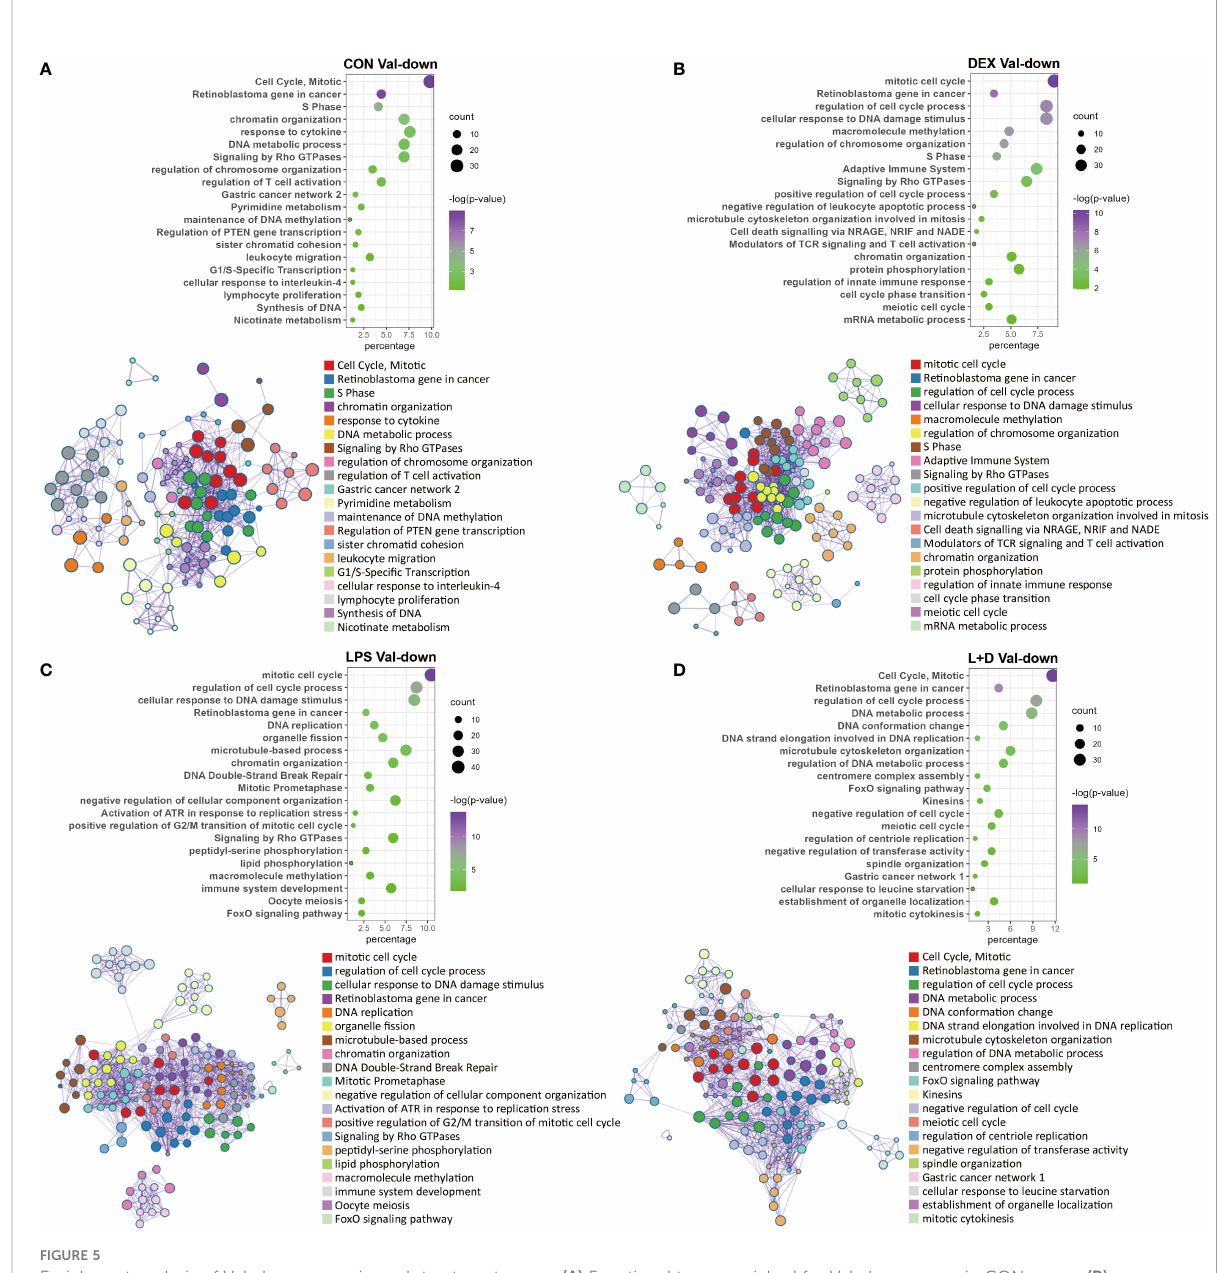
FIGURE 5 Enrichment analysis of Val-down genes in each treatment group. (A) Functional terms enriched for Val-down genes in CON group. (B) Functional terms enriched for Val-down genes in DEX group. (C) Functional terms enriched for Val-down genes in LPS group. (D) Functional terms enriched for Val-down genes in LPS+DEX group. Enrichment analysis was performed using the Metascape. Bubble plots illustrate signi fi cance and gene counts of top enriched terms, where purple indicates higher signi fi cance and green indicates lower signi fi cance and bubble size is positively correlated with gene counts. Networks illustrate the relationship between terms, where each node represents one functional term and terms with Kappa similarities above 0.3 are connected by edges. Each term cluster is labeled and represented by its most signi fi cant member and all members in the same term cluster are indicated by the same